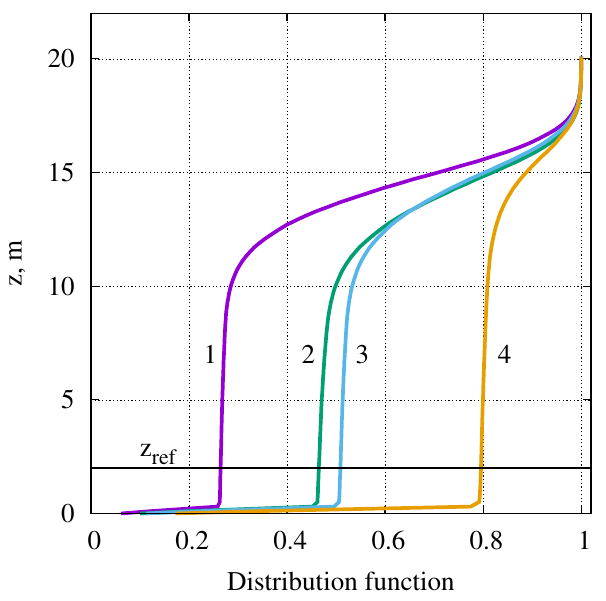
Figure 2. Distribution function of ALS hits in the RAMI pine stand. 1—first hits, 2—all hits, 3—weighted hits, 4—last